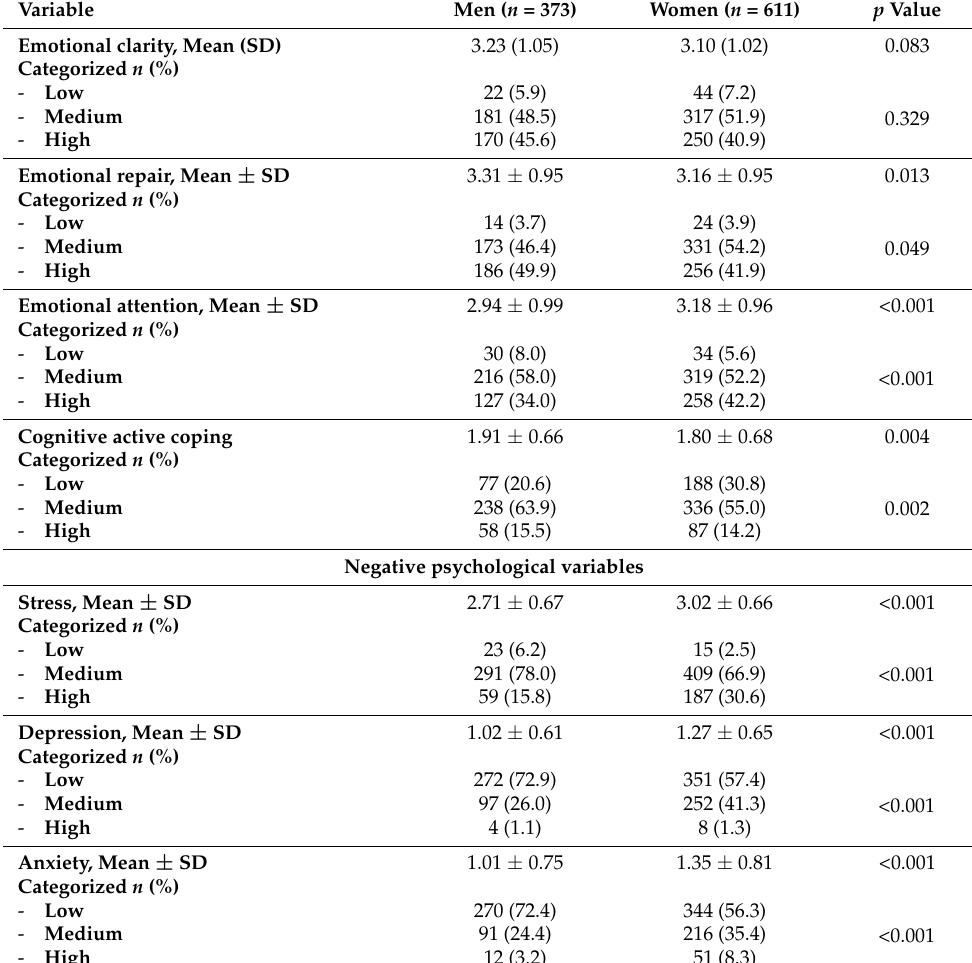
Table 2. Comparison of emotional intelligence and negative psychological variables between sexes.